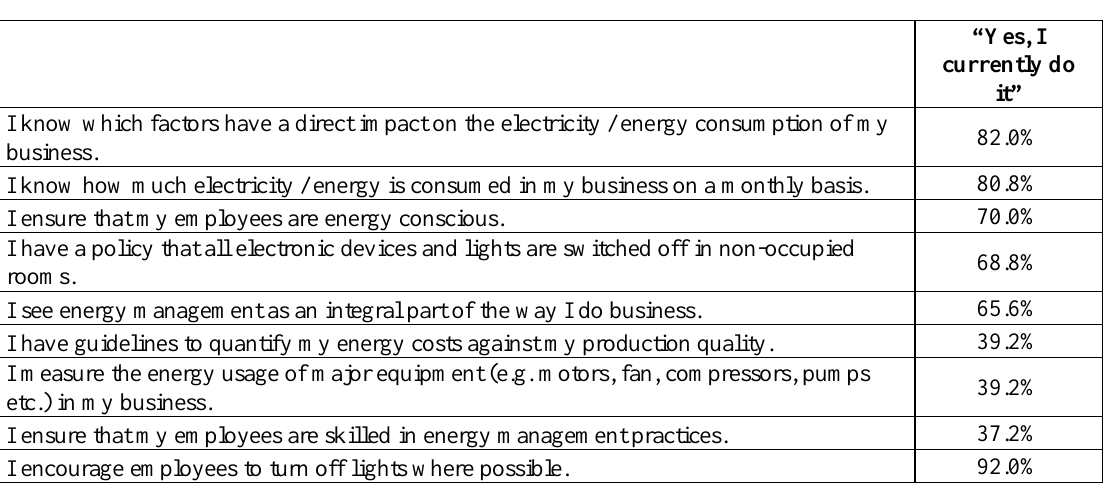
Table 4: Energy conservation